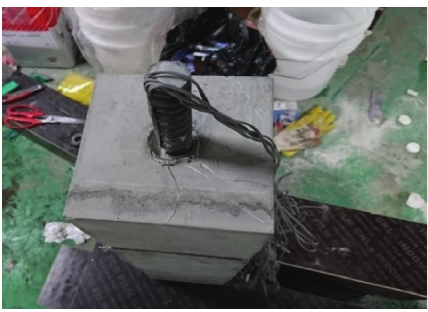
Figure 16: Finishing work by glue